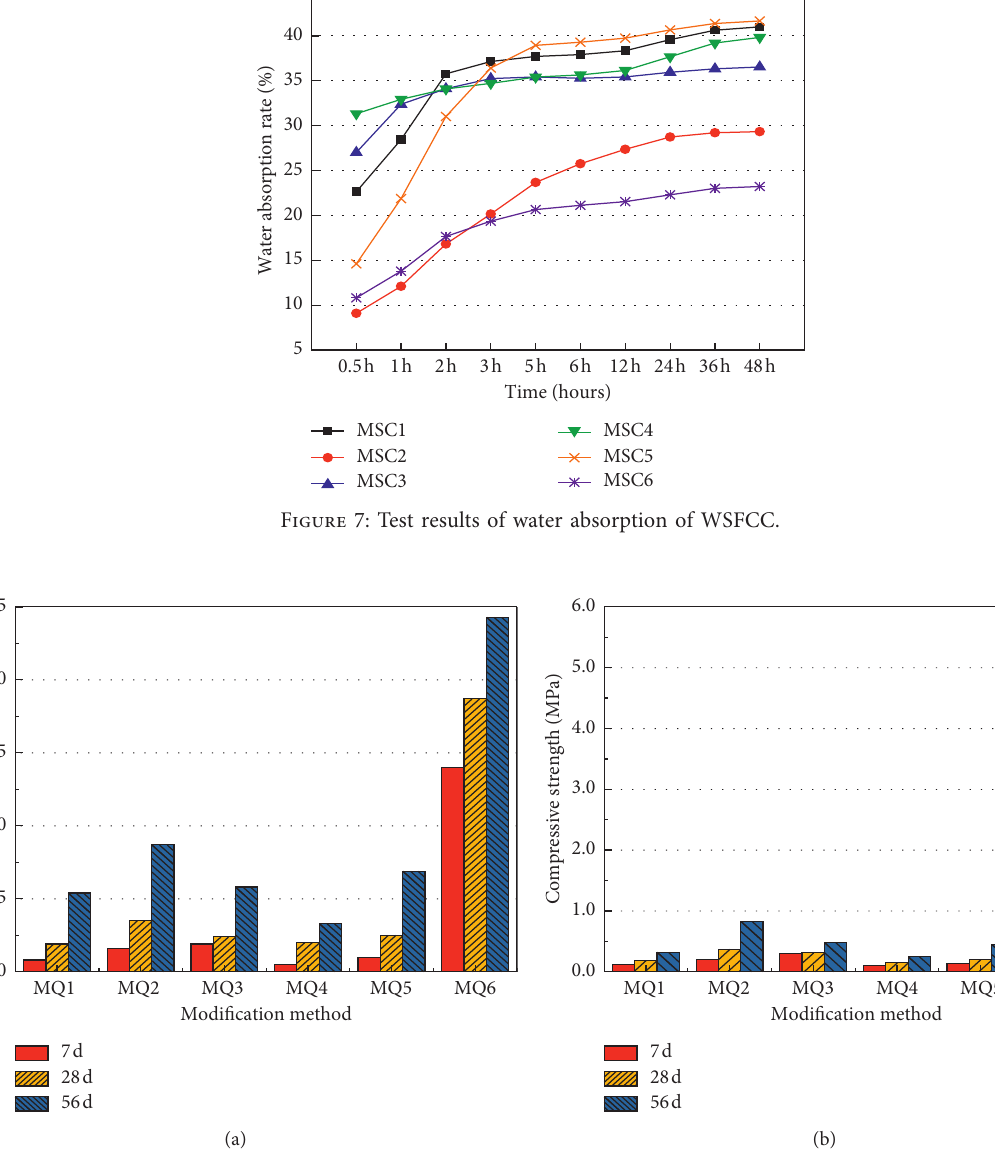
Figure 8: Strength of wheat straw fiber cement-based materials. (a) Flexural strength. (b) Compressive strength.